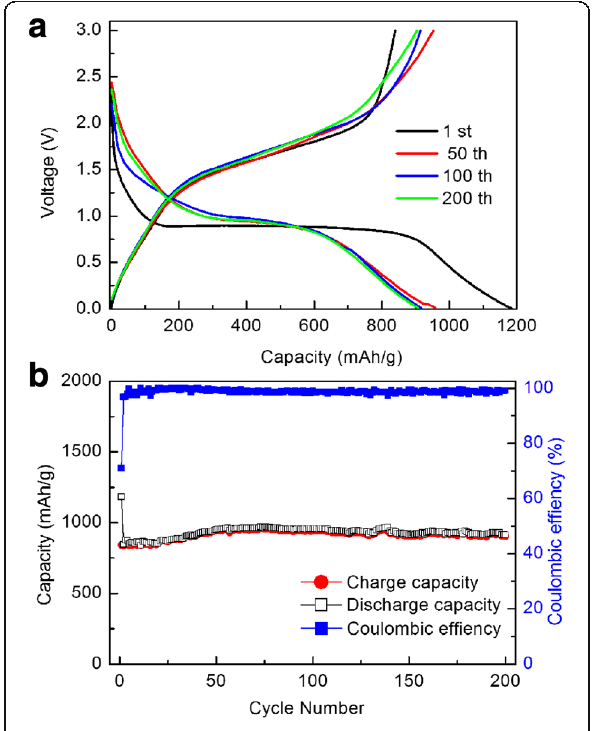
Fig. 4 a Discharge-charge profiles of the nanocrystalline Fe 2 O 3 film anode cycled between 0.01 – 3 V at a specific current of 100 mA g − 1 . b Cycling performance of the nanocrystalline Fe 2 O 3 film anode and corresponding Coulombic efficiencies at a specific current of 100 mA g − 1